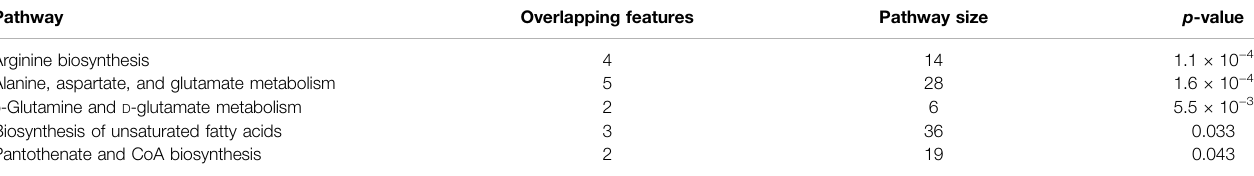
TABLE 4 | KEGG enrichment pathways altered in PDR patients compared with NPDR patients. Pathway